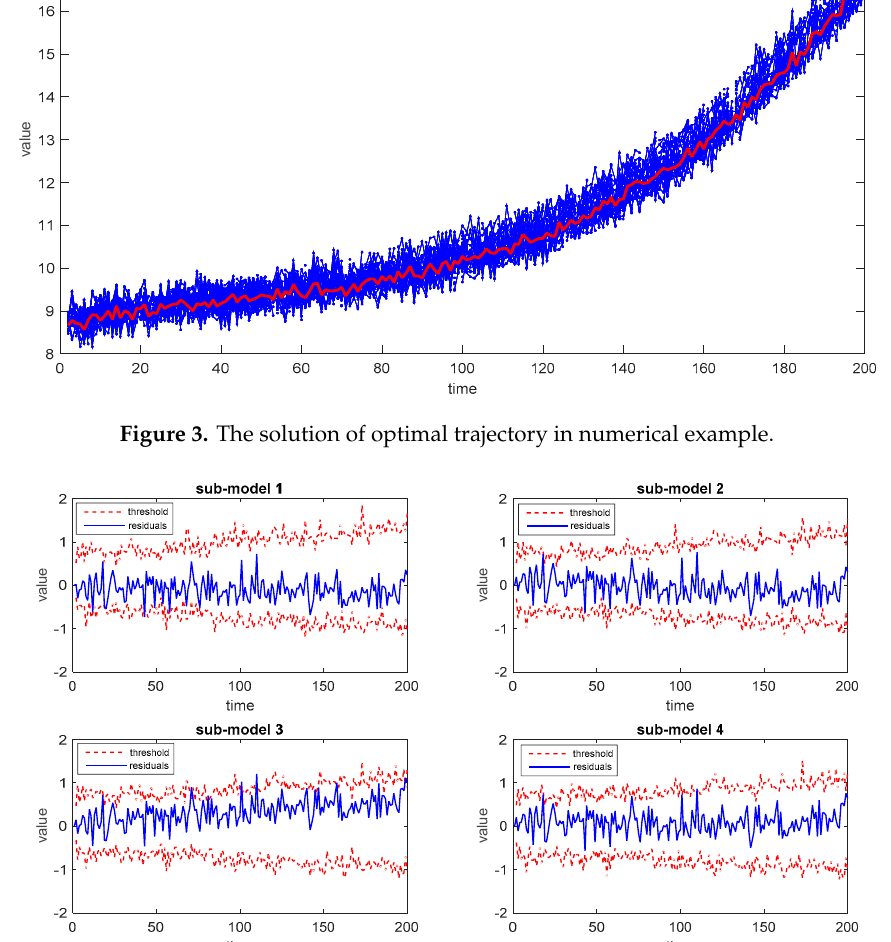
Figure 4. Monitoring results of the normal batch in numerical example.